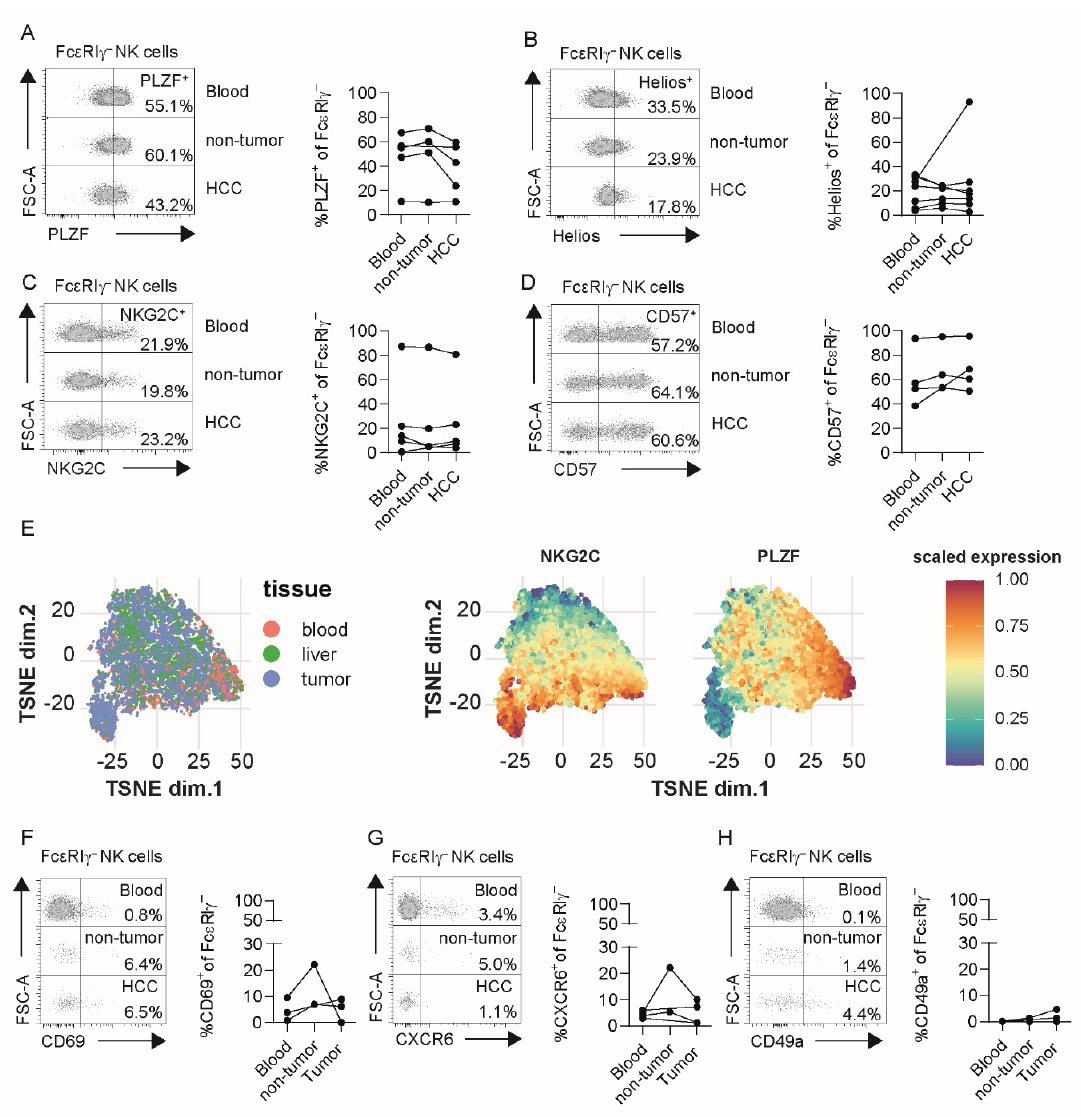
Figure 2. Similar adaptive signature in NK cells isolated from tumor tissue and peripheral blood in HCC patients. PLZF ( A ), Helios ( B ), NKG2C ( C ) and CD57 ( D ) expression of Fc ε RI γ − CD56 dim NK cells in blood ( n = 5 in A and C , n = 7 in B, n = 4 in D), adjacent non-tumoral liver ( n = 4 for ( A , C ), n = 6 for ( B ), n = 3 for ( D )) and HCC tissue ( n equal to blood) of HCMV + HCC patients. T-SNE analysis of concatenated flow cytometry data obtained from Fc ε RI γ − CD56 dim NK cells in blood ( n = 5), adjacent non-tumoral liver ( n = 4) and HCC tissue ( n = 5) of HCMV + HCC patients ( E ). Expression levels of NKG2C and PLZF are depicted in the t-SNE plots (left). CD69 ( F ), CXCR6 ( G ) and CD49a ( H ) expression of Fc ε RI γ − CD56 dim NK cells in blood ( n = 3 for ( F , H ), n = 4 for ( G )), non-tumor ( n = 2) and HCC tissue ( n equal to blood) of HCMV + HCC patients. Each point represents a single HCMV + patient, and lines connect the samples from one patient. Bars indicate median with IQR. Statistical significance was tested using the Kruskal–Wallis test ( A – D ) and mixed-effect analysis ( F – H ). HCC: hepatocellular carcinoma.